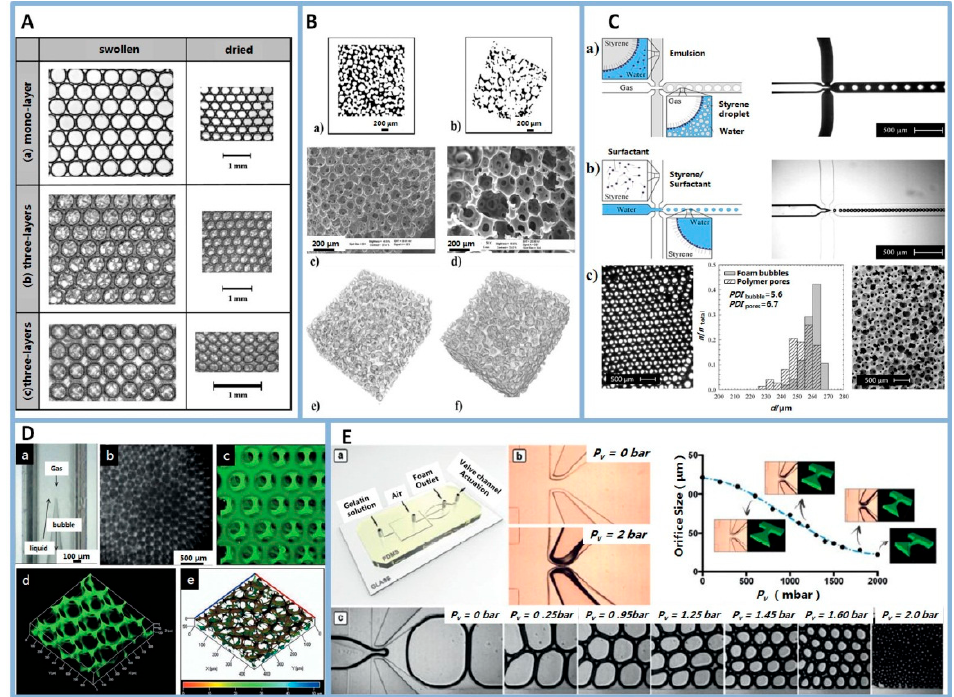
Figure 4. ( A ): Ordered polymerised foam layers in the swollen and dried state obtained by confining the initially liquid foam between narrowly spaced glass plates. (a) mono-layer packing, (b) three-layers packing in the (1 1 1) direction of the fcc packing, (c) three-layers packing in the (1 0 0) direction of the fcc packing. Reprinted from [60] with permission. Copyright 2009 Elsevier. ( B ): Microcomputed